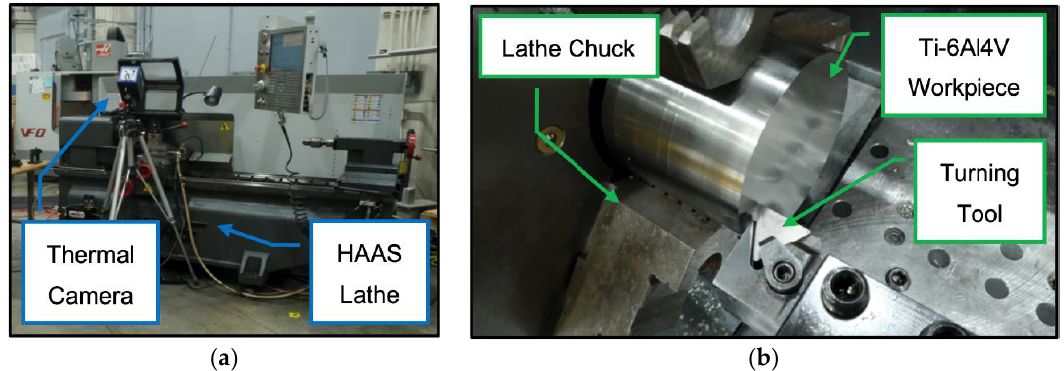
Figure 3. ( a ) HAAS TL2 CNC lathe used to perform cutting tests; ( b ) Kennametal TPGN K-68 tool of r c = 0.8 mm tool being touched off the Ti-6Al4V workpiece.